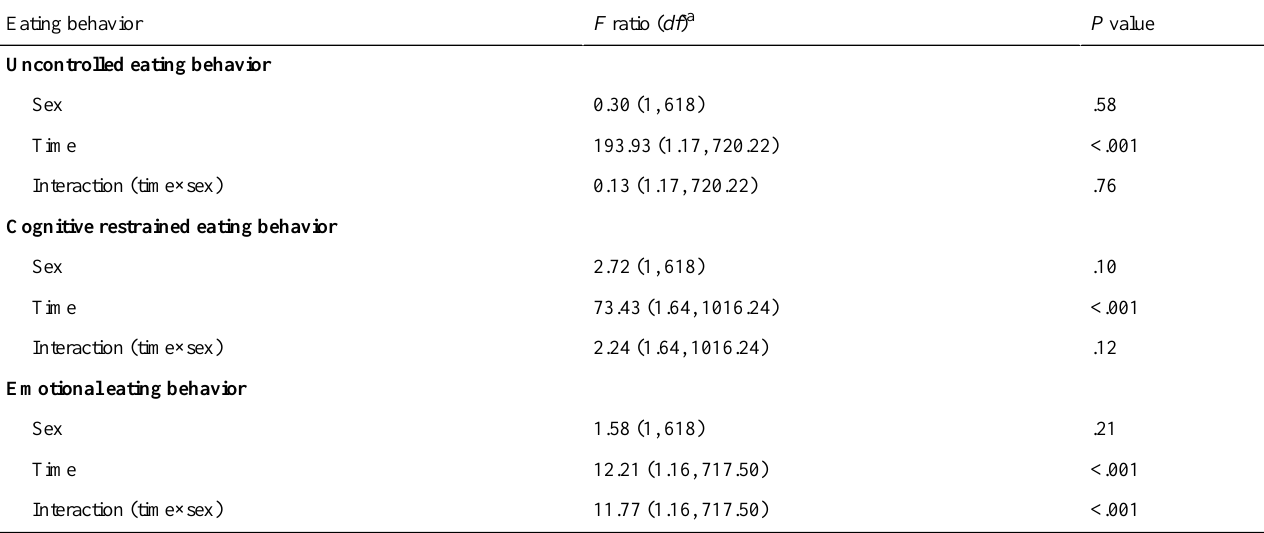
Table 2. Results of repeated measures